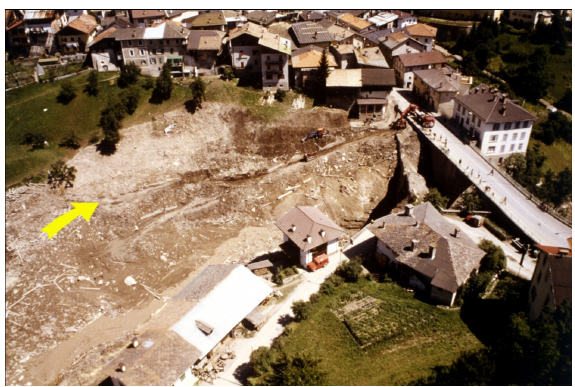
Fig. 14 ‐ The effects produced by the mudflow in Tesero, upstream of the two bridges. For the curvature of the axis to the right valley, the mass raised considerably on the left side to 10 m more than the right bank (photo CNR ‐ IRPI Torino, July 20, 1985).